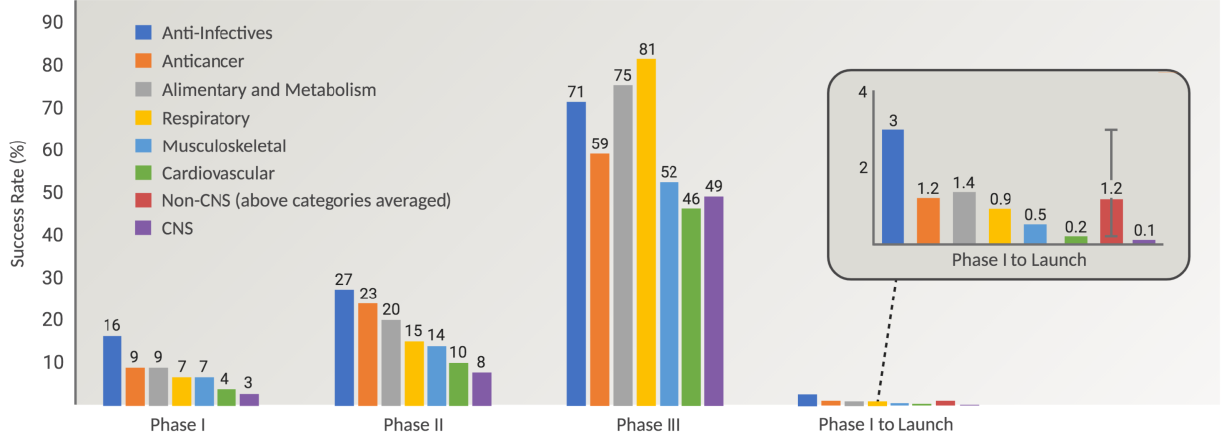
Figure 2. Success rates of clinical trial phases categorised by disease type from 2010–2017. The CMR R&D Performance Metrics reported the average clinical phase success rate of pharmaceutical drugs that treat the most common disease areas from 2010–2017. Combining the success rate of each phase provides the success rate probability of a drug from phase I to launch. Averaging the combined phase success rates of non-CNS drug categories leads to an average 12-fold greater success rate relative to CNS drugs, highlighting the high failure rate of CNS drug candidates in drug development. Data taken from ref. [19], with additional extrapolations made.